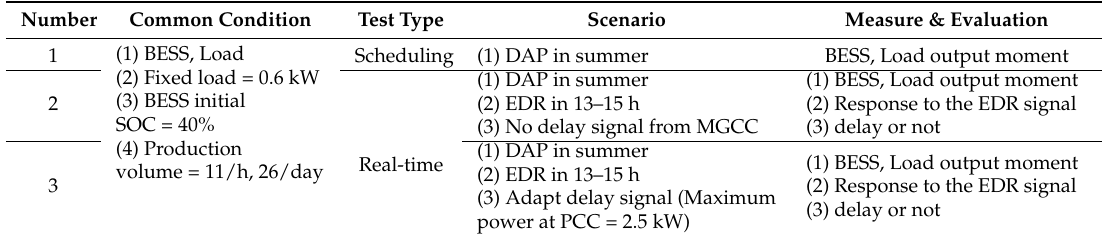
Table 3. Scenario for the proposed algorithm.